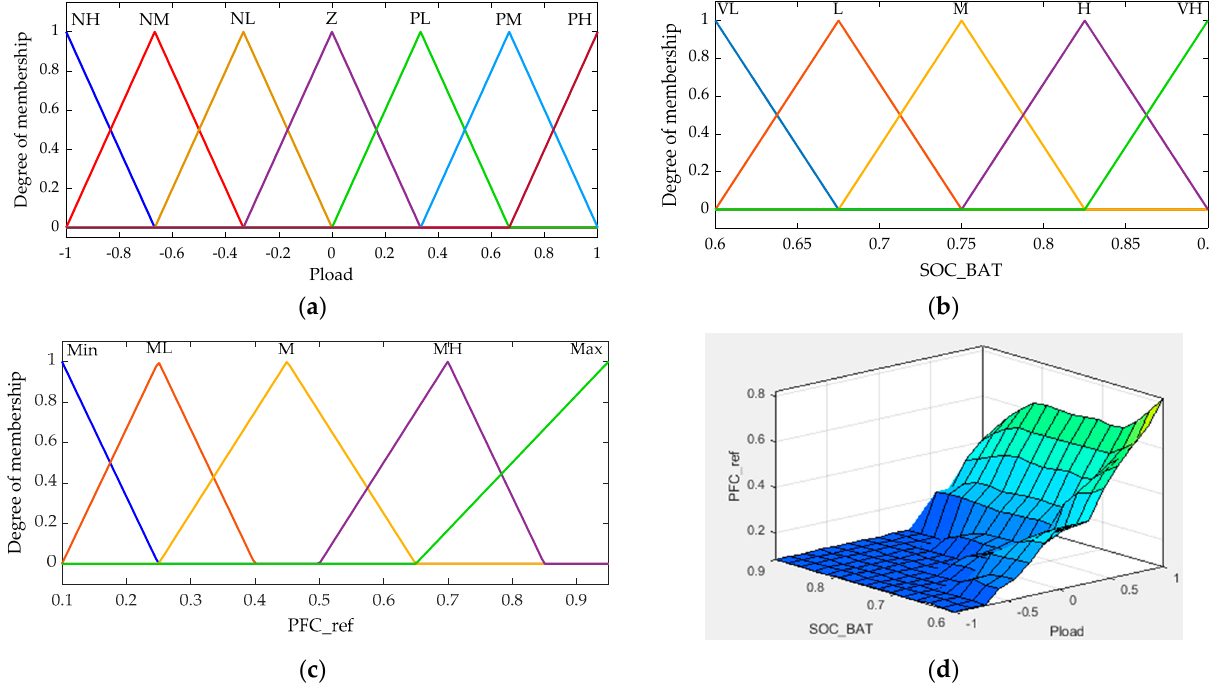
Figure 7. MFs of the FLRs. ( a , b ) MFs of inputs; ( c ) MFs of output; ( d ) Graph of inputs and output. Table 1. Fuzzy reasoning rules.